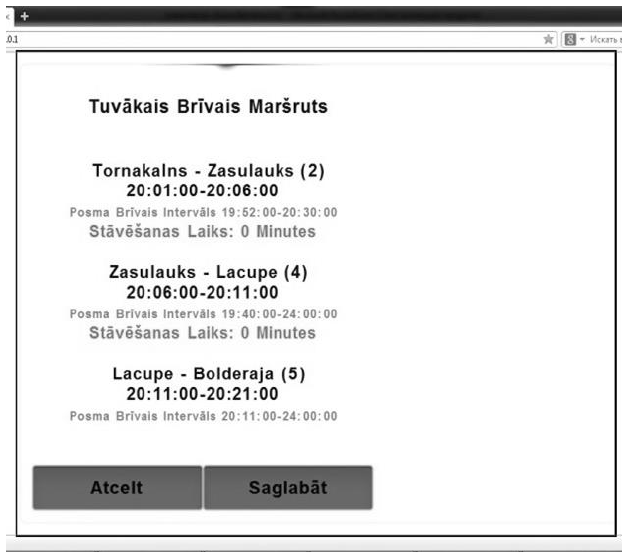
Fig. 9. Result after the